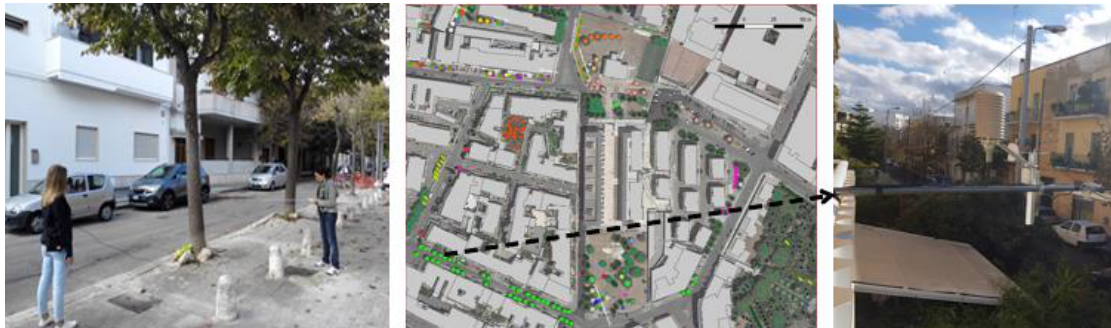
Figure 4. San Pio neighbourhood. Lead area index (LAI) measurements with the ceptometer (left) and map (middle) with indication of the position (VD in Figure 3) of the thermo-hygrometer (right) employed for the validation of ENVI-met simulations (see subsection 3.4).